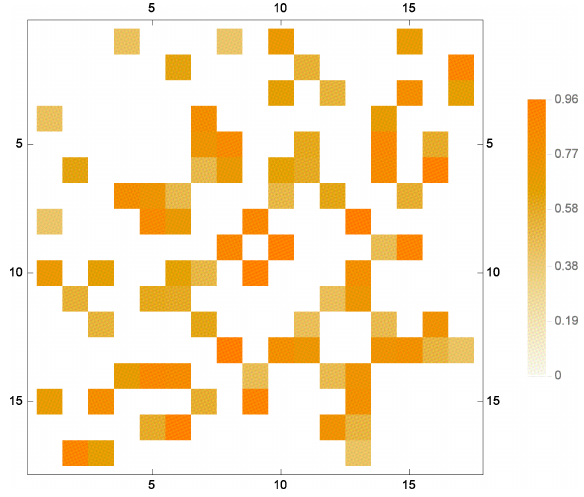
Fig. 4. The matrix W obtained by the CorrDist of each adjacent stock market. The matrix is plotted with the temperature mapping and each ticks are mapped to stock markets in alphabetical